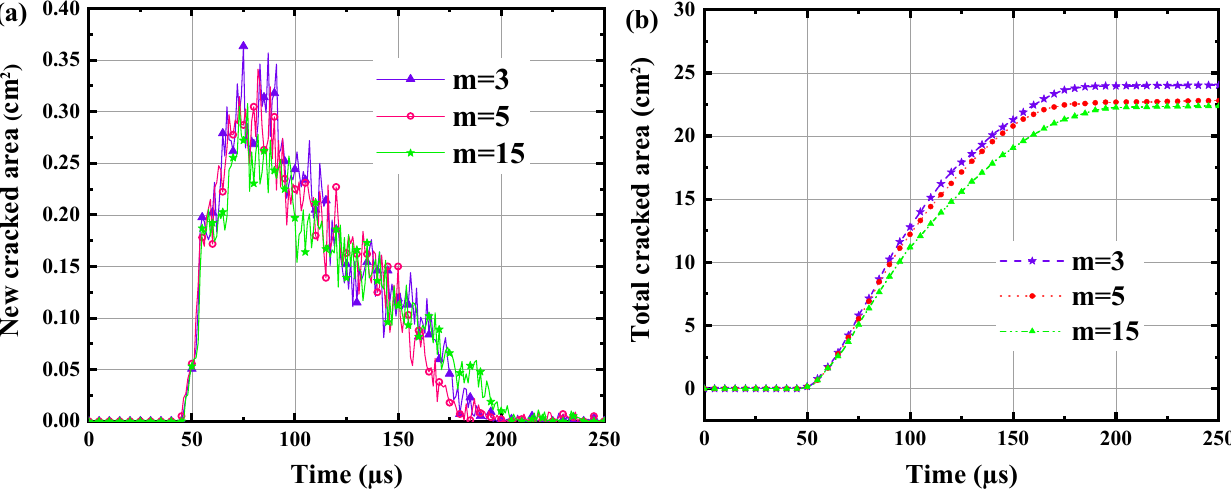
Figure 21. Temporal evolution of ( a ) new cracked area and ( b ) total cracked area in the granite under high voltage electropulse for different homogeneity indices m = 3, 5, 15.